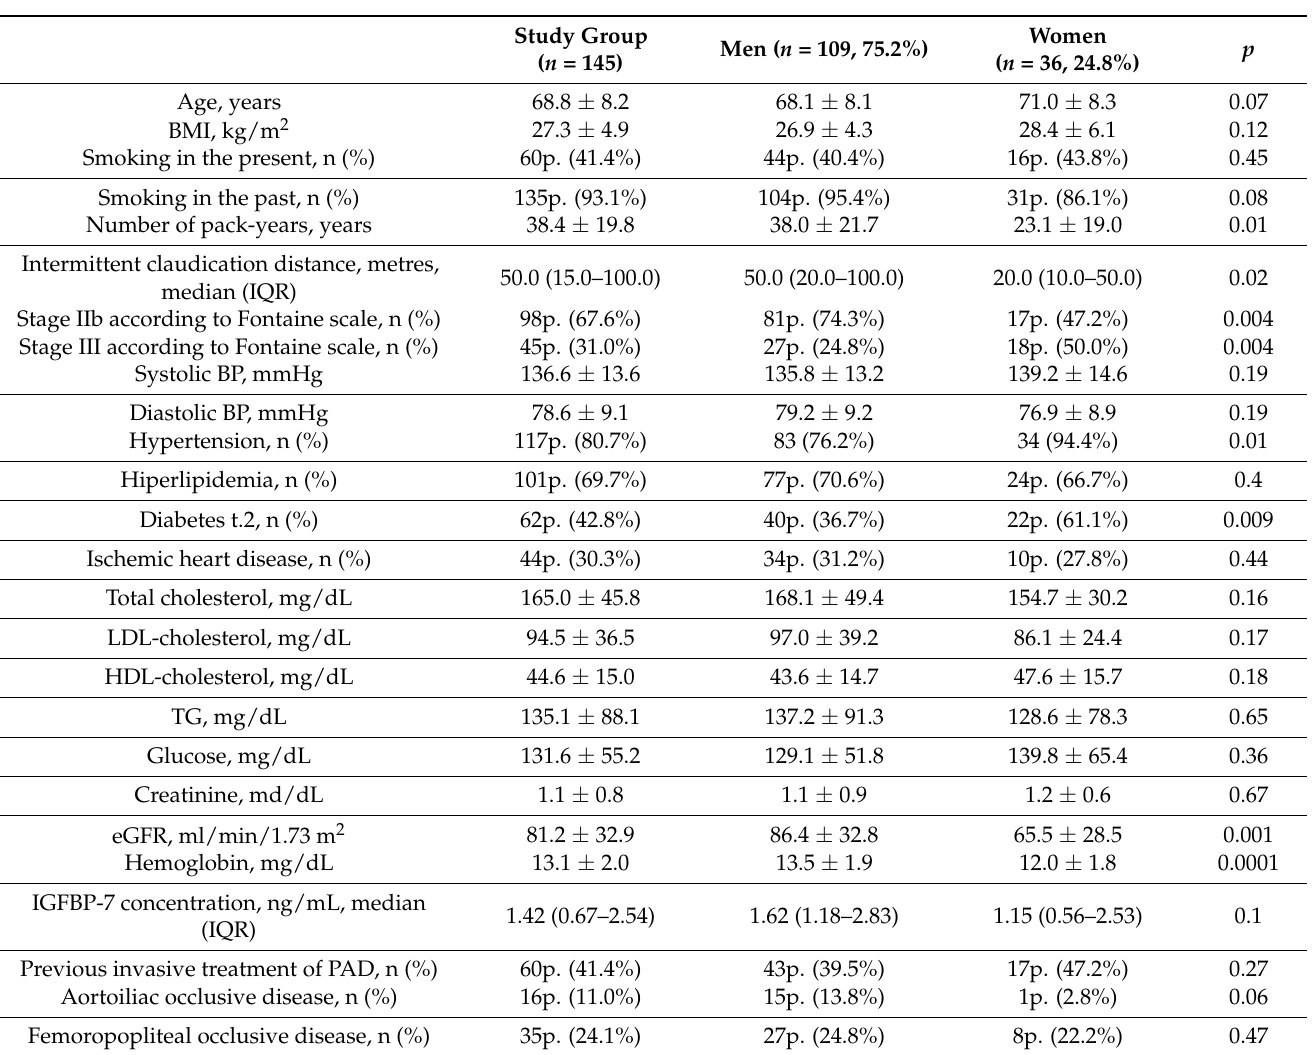
Table 2. Patient characteristics with gender